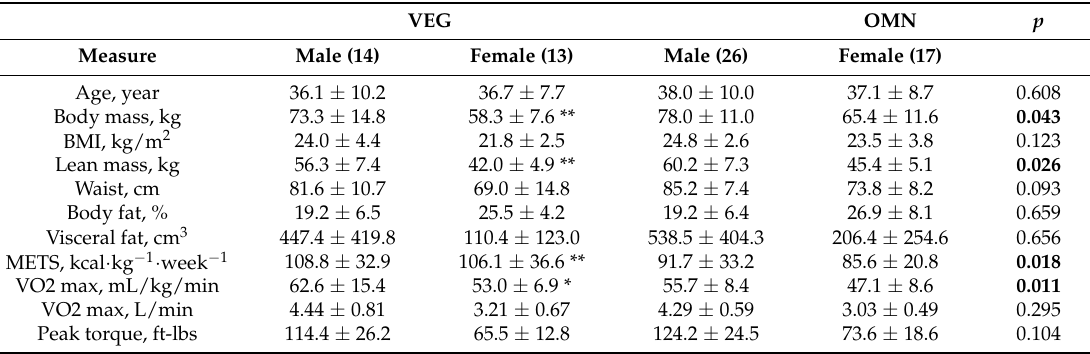
Table 1. Participant characteristics by diet group (vegetarian, VEG; omnivorous, OMN) 1 .